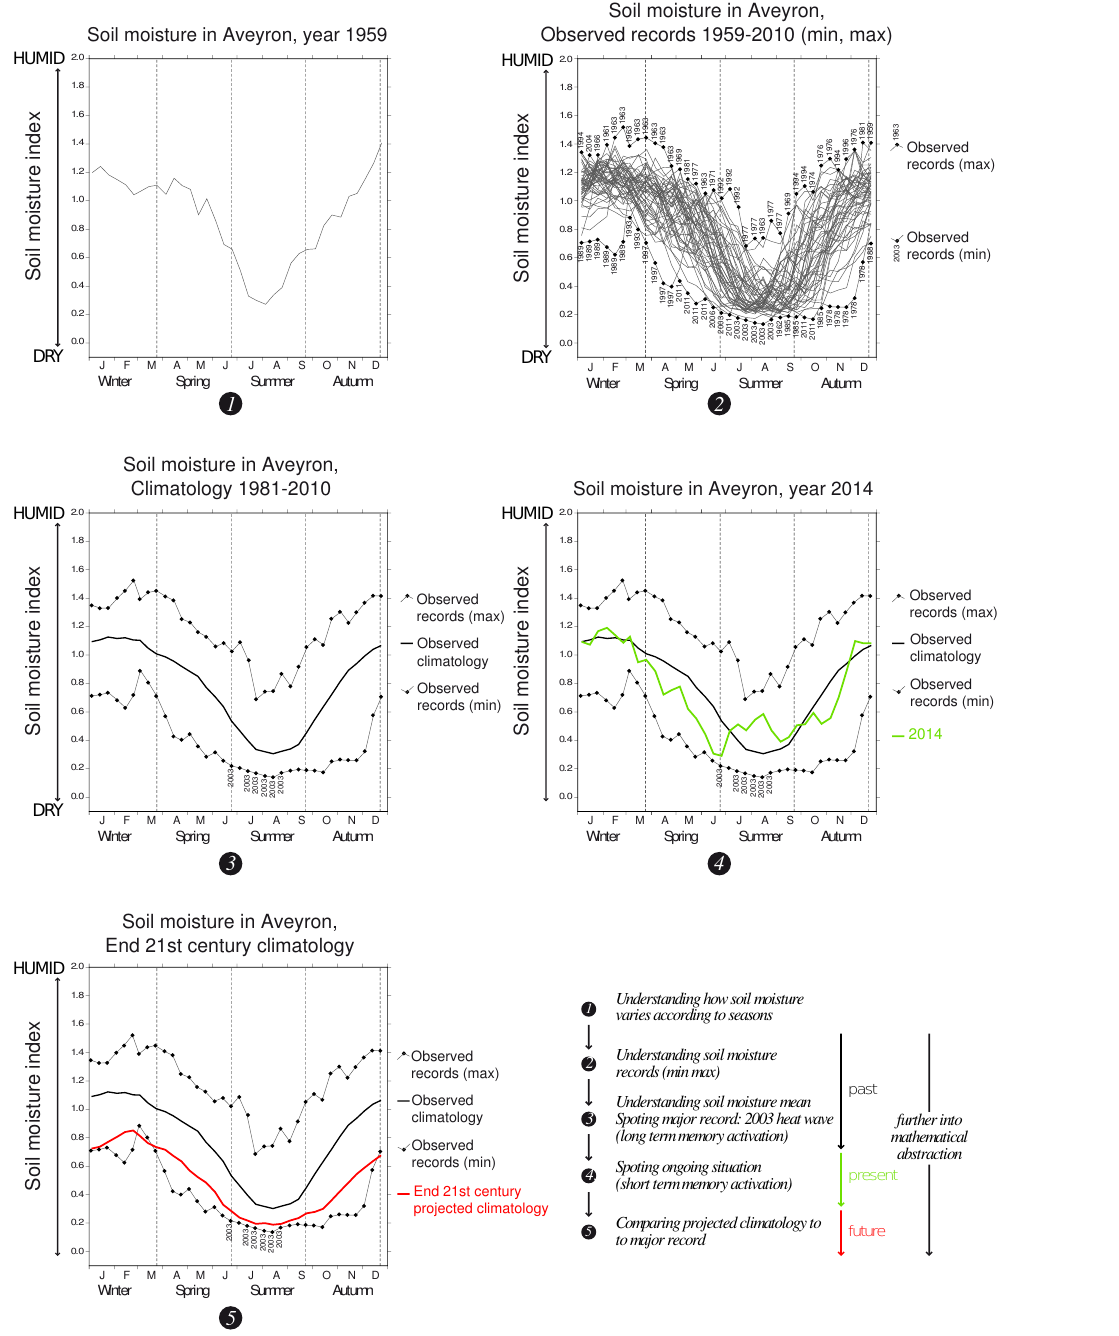
Figure 3. Attempt to ease the understanding of the product presented in Fig. 1, by using animations and storytelling.